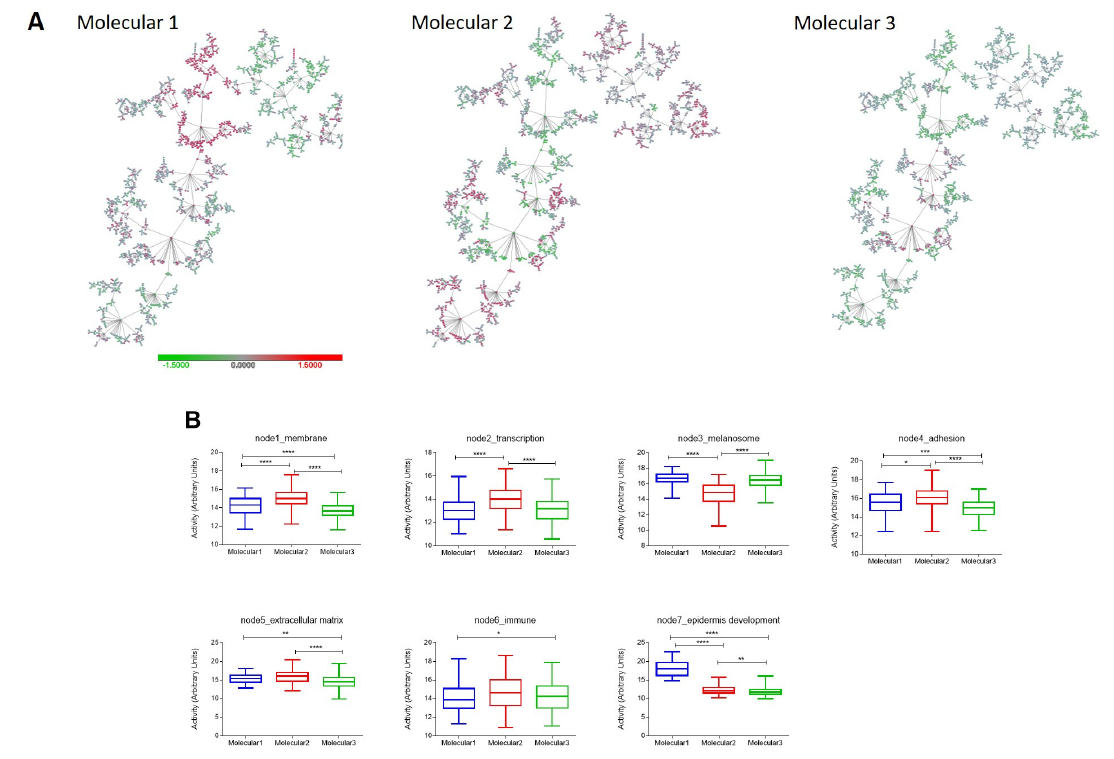
Figure 4. Molecular classification grouping information of molecular layers defined in the TCGA melanoma cohort. ( A ) Groups obtained using molecular information. ( B ) Functional node activities in molecular groups. ****, p ≤ 0.0001; ***, p ≤ 0.001; **, p ≤ 0.01; *, p ≤ 0.05. Molecular 1, which included 70 patients (16%), was characterized by higher activity of the functional node “epidermis development” and lower activity of the node